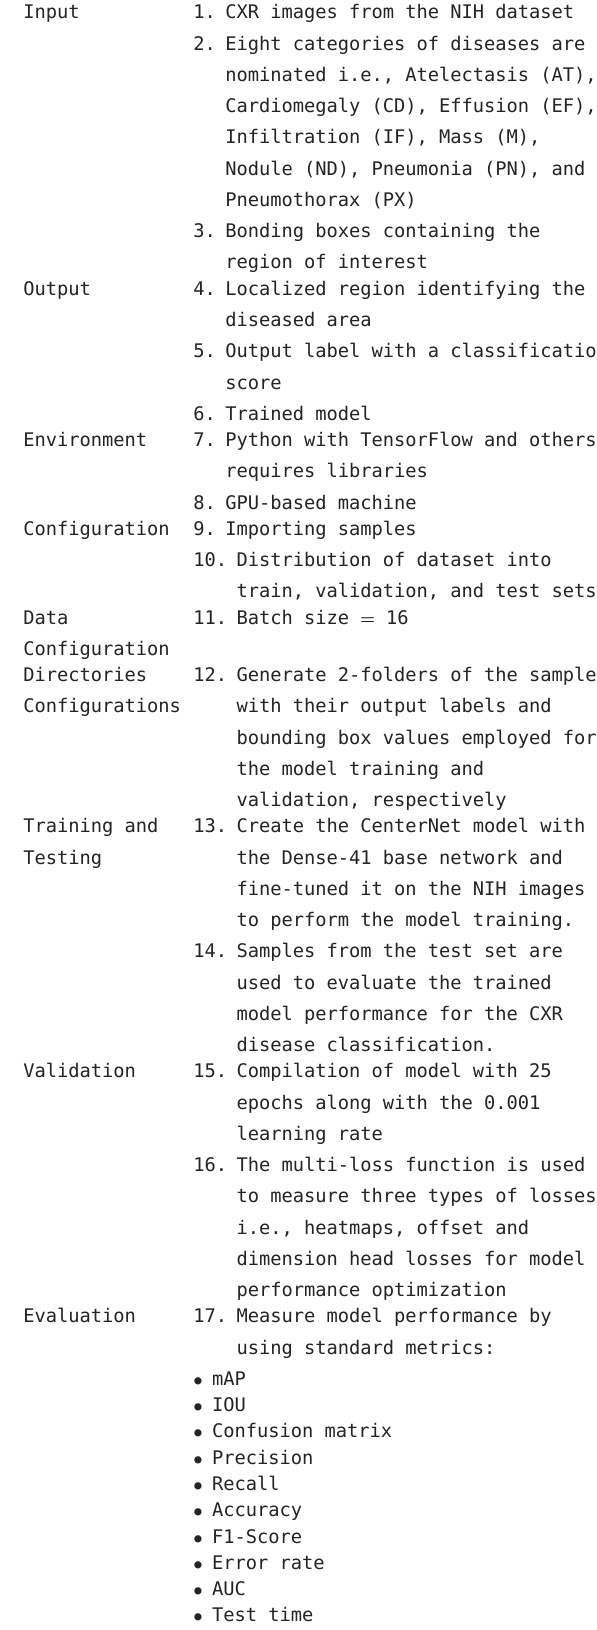
Algorithm 1. Flow of the introduced